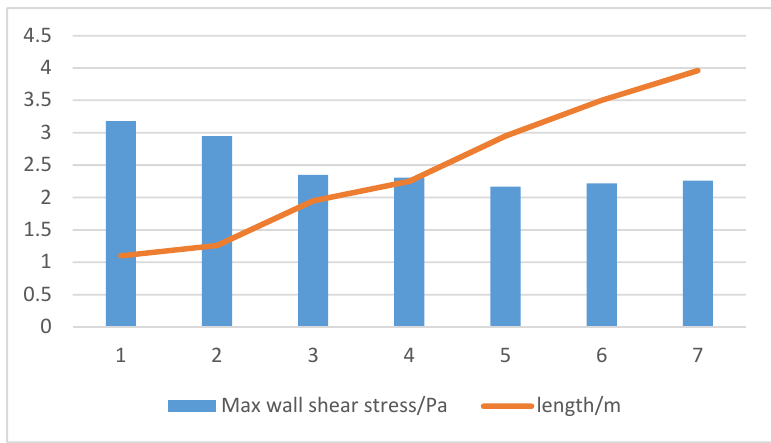
Figure 8. Effect of membrane module length on wall shear stress. Figure 8. E ff ect of membrane module length on wall shear